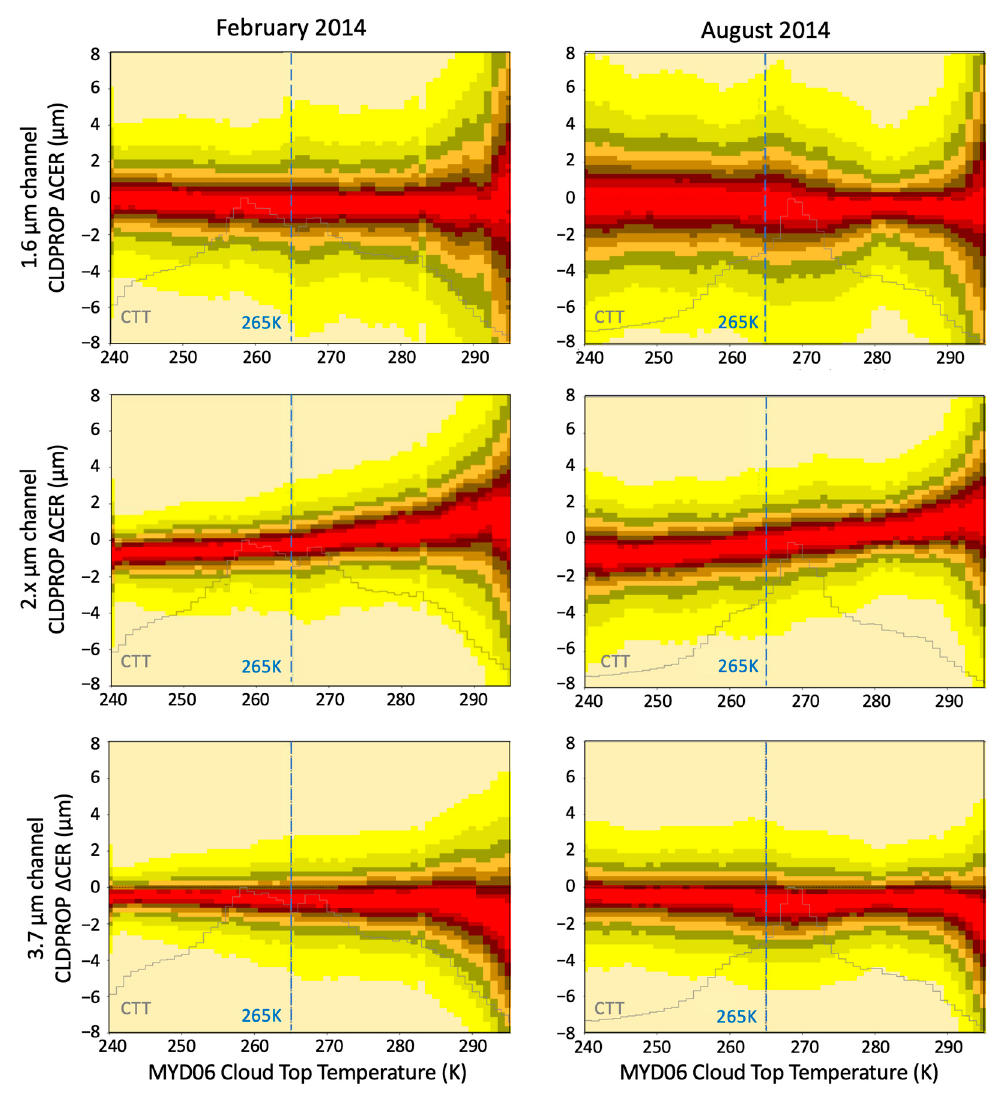
Figure 9. Monthly distribution of cloud continuity products (CLDPROP) v1.1 liquid water spectral CER VIIRS minus MODIS di ff erences for February 2014 ( left column ) and August 2014 ( right ). Each cloud-top temperature (CTT) bin is normalized to its maximum count. The 265 K temperature corresponding the index of refraction datasets used in the CLDPROP algorithms are shown as a reference. The CTT distribution (solid gray line) is taken from the MODIS standard product (MYD06) which was available in the merged files used for the analysis (see text for